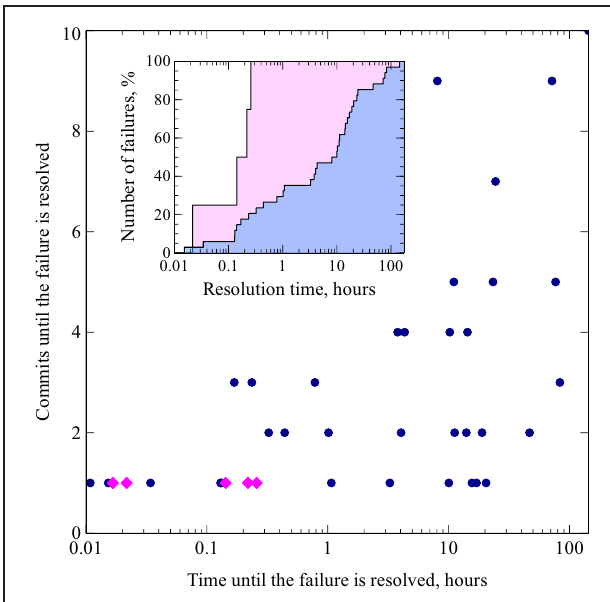
FIGURE 7 | Scatter plot illustrating the relationship between the number of commits and the amount time that it took to fix a build failure. Failures that occurred between September, 2008 and September, 2011 are marked with blue circles, failures that happened since October, 2011 (when instant build failure notifications were enabled thanks to the CI system) are marked with magenta diamonds; time values are represented on a logarithmic scale, while the numbers of commits are equally spaced. The inset shows the same data in the form of a cumulative histogram: the proportion of build failures on the vertical axis is plotted against the time until the failure is resolved on the horizontal axis (logarithmic scale). The blue area corresponds to the blue circles on the scatter plot (failures that occurred before the introduction of CI notifications) and the pink area corresponds to the magenta diamonds (failures that happened